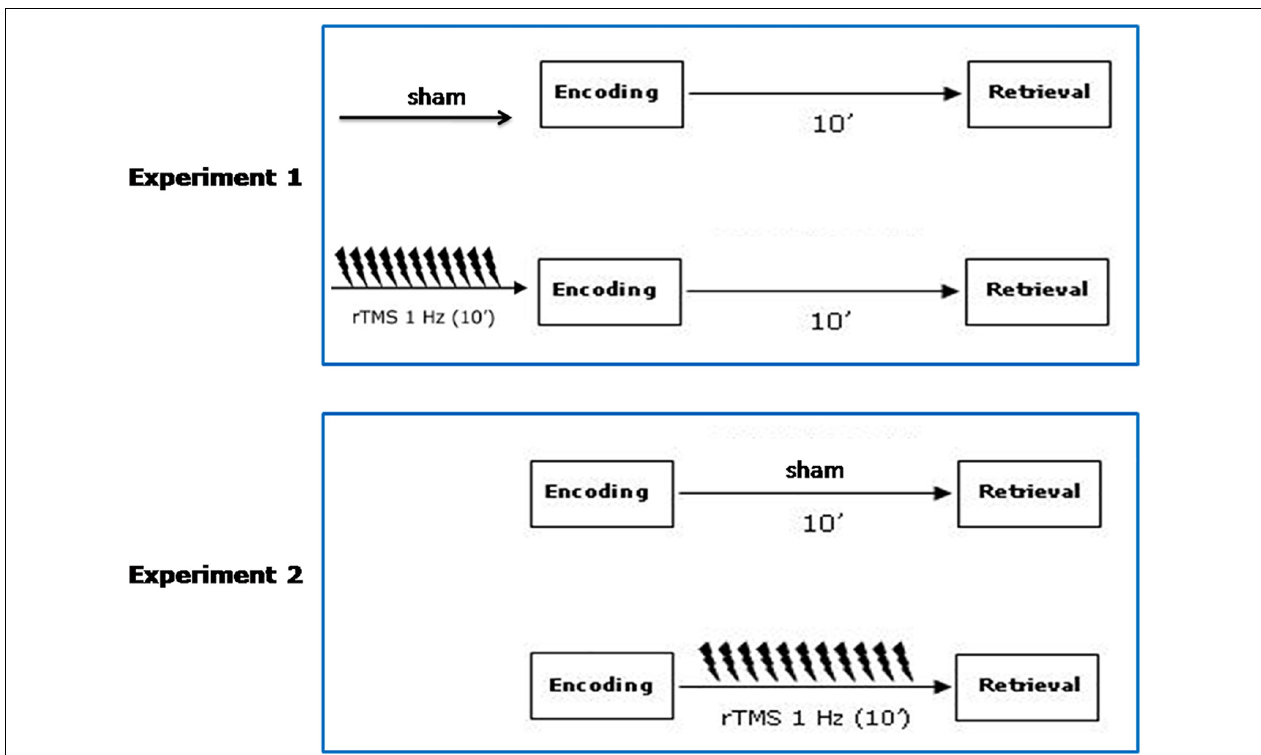
FIGURE 1 | Schematic diagram of the experimental procedure. Participants received sham and active rTMS, in two counterbalanced separate sessions on the same day. A 6 h washout interval was applied. In Experiment 1, sham/active rTMS over the left and the right PPC was given before the encoding phase. In Experiment 2, sham/active rTMS over the left and the right PPC was given before the retrieval phase.